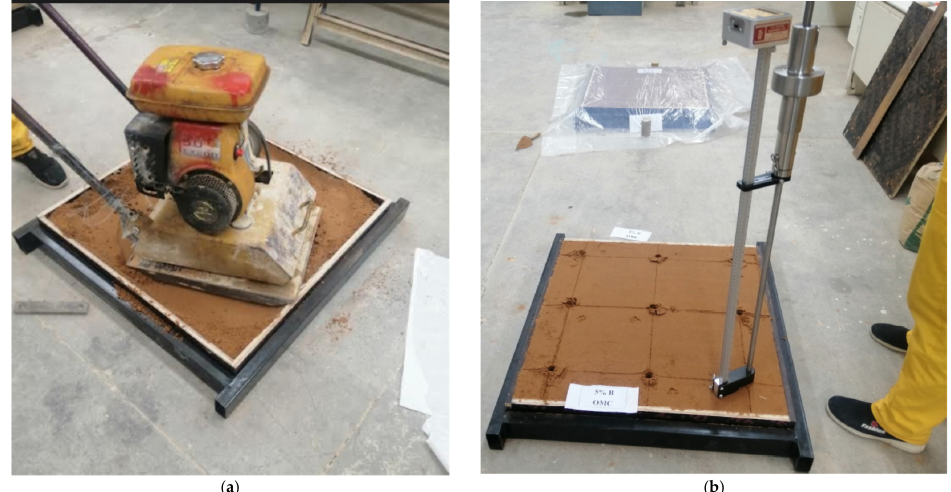
Figure 3. Preparation of laboratory model for a clay–sand liner cover layer. ( a ) Compacting a layer to the required density. ( b ) Testing points using a dynamic penetrometer. the required density. ( b ) Testing points using a dynamic